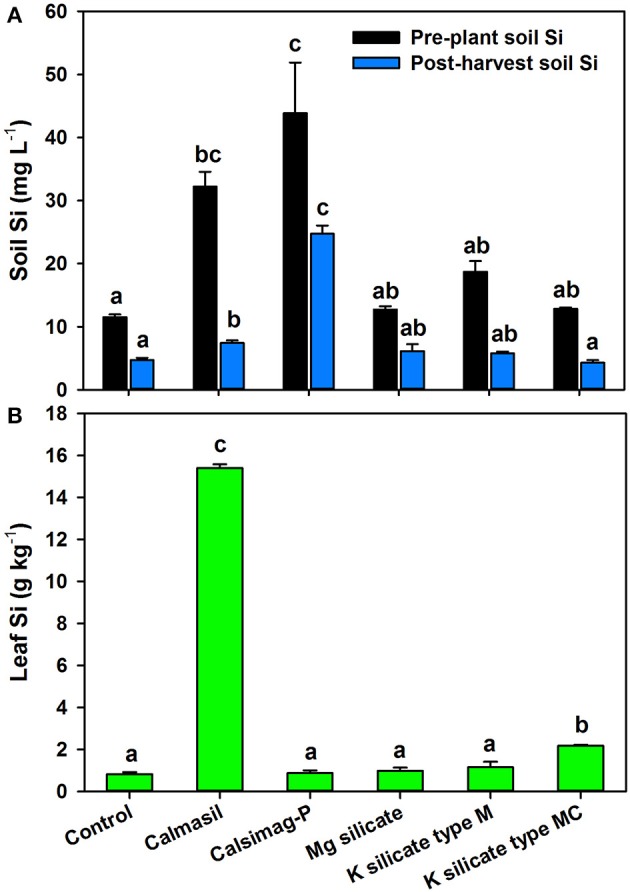
Silicon concentrations in soil (A) and third leaf (B) following application at rates specified in Table 3 of different silicon sources (represented on X-axis) in Trial 1. The control was untreated. In (A), black bars represent pre-plant soil and blue bars represent post-harvest soil; mean values for bars of the same color and with the same letter/s above them are not significantly different. In (B), mean values for bars with the same letter above them are not significantly different (Holm-Sidak test, P < 0.05; ANOVA, P < 0.001 for soil and leaf Si). Error bars are standard errors. Mg silicate = Prosil Plus